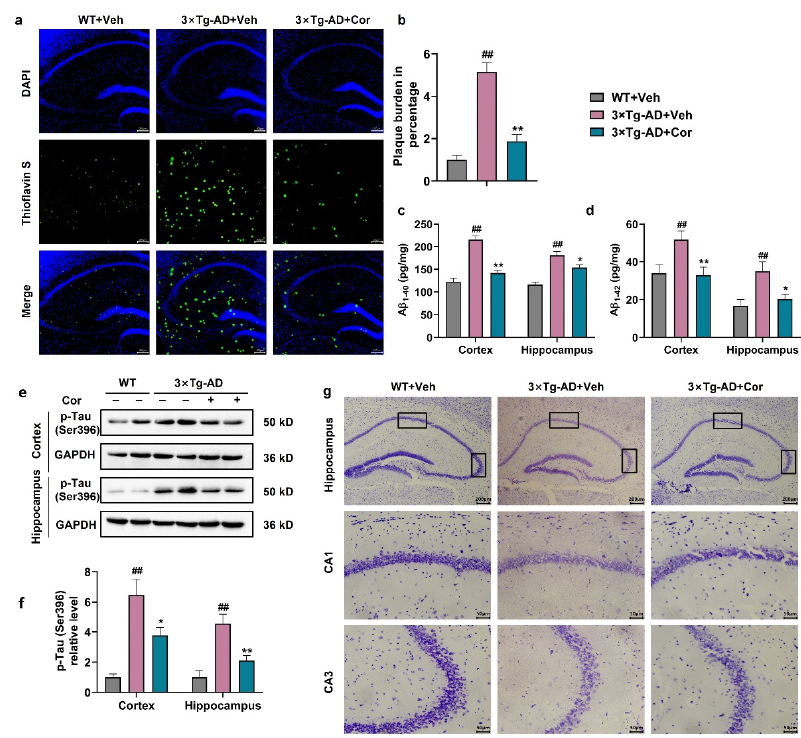
Figure 2. Cornuside improved the histomorphology, reduced amyloid plaque and inhibited Tau phosphorylation in the 3 × Tg-AD mouse brains. ( a ) Representative Thioflavin S immunofluorescent images of A β plaque-occupied hippocampal region for the 3 × Tg-AD + Veh, 3 × Tg-AD + cornuside, and WT + Veh mice ( n = 4 in each group). Scale bar for original micrographs = 200 μ m. ( b ) Surface area quantification for the A β plaques. ( c , d ) The level of A β 1-40 ( c ) and A β 1-42 ( d ) in each experimental group ( n = 5 per group). ( e ) The representative images and ( f ) quantification analysis of p-Tau (Ser396) protein in the hippocampi and cortices of 3 × Tg-AD mice with or without cornuside treatment compared with WT control mice ( n = 6 per group). ( g ) Nissl’s staining of the neuronal cells and typical micrographs from every experimental group. Scale bar for original micrographs = 200 μ m, whereas that for enlarged graphs = 50 μ m. Data are all expressed as mean ± SEM. ## p < 0.01 compared with WT + Veh; * p < 0.05 and ** p < 0.01 compared with 3 × Tg-AD mice + Veh.